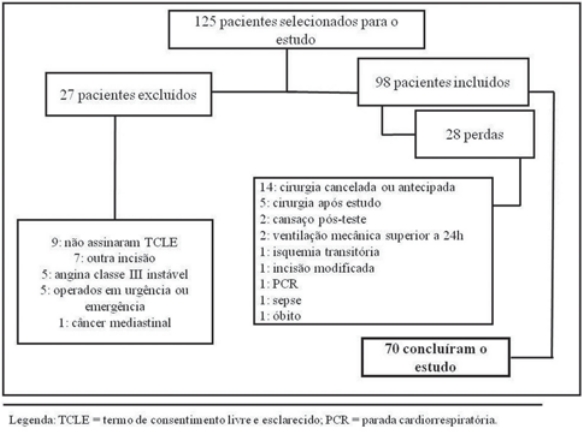
Fig.1 - Dados dos pacientes relacionados para o